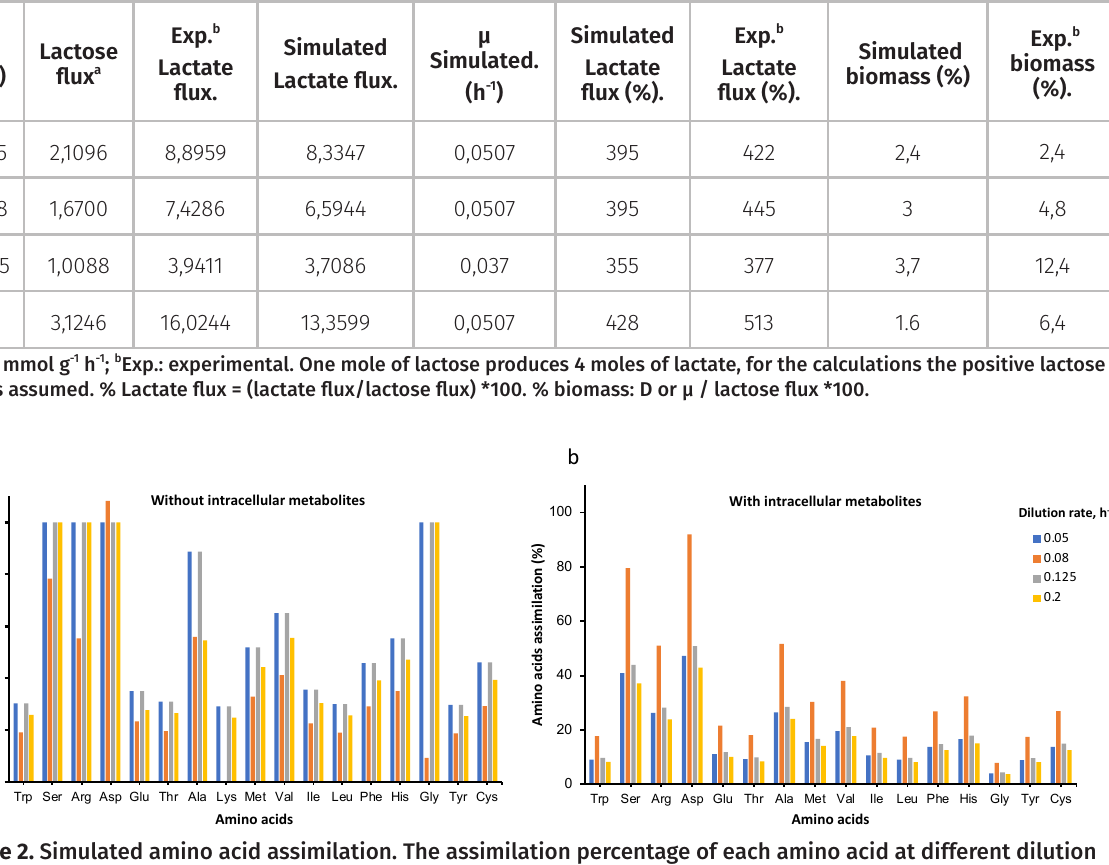
Table III. Comparison of lactate flux and biomass synthesis for Lacticaseibacillus paracasei and i Lca334_548 model.